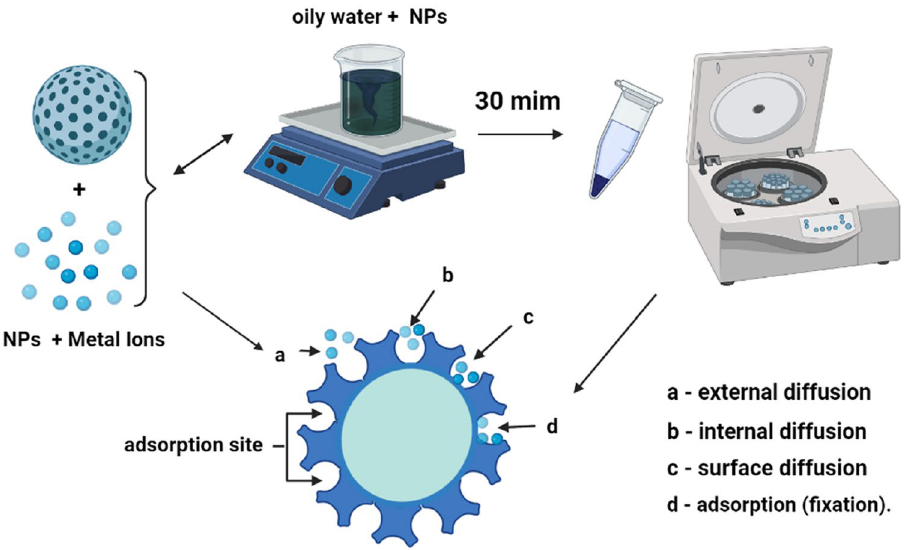
Figure 7. Schematic of the experiment and Mechanism of the transfer of an adsorbate to the adsorption site within a